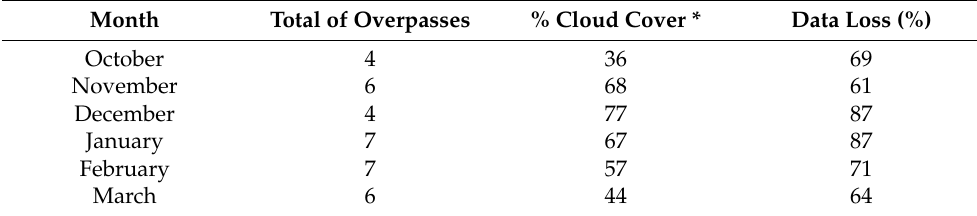
Table 6. Total of overpasses, average cloud cover, and percent data loss in the Harmonized Landsat Sentinel-2 images caused using the F-mask in the study